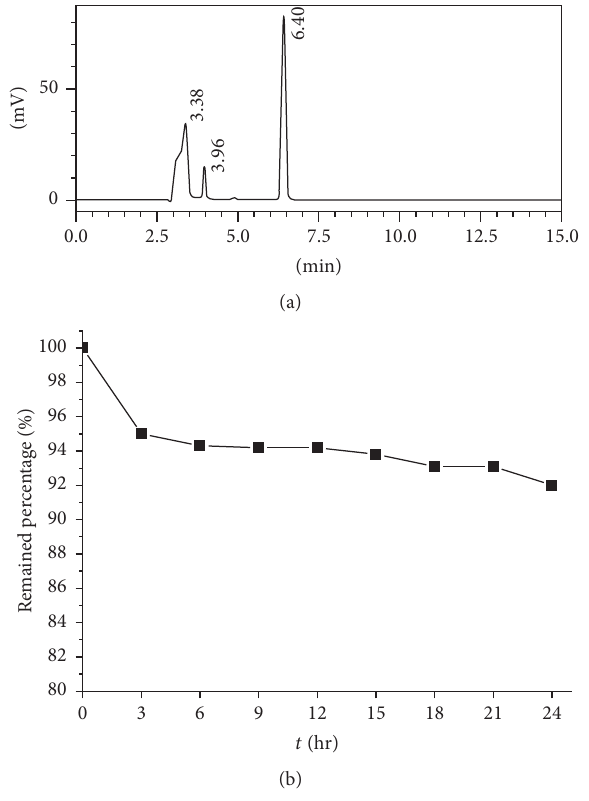
Figure4:(a)HPLCchromatogramofbiotin(internalstandard)and ( 8 ) in plasma after 3h incubation time; retention time of biotin and plasma: 3.38 min, ibuprofen: 3.96 min, and ( 8 ): 6.40 min and (b) the remained percentage of ( 8 ) in plasma over incubation